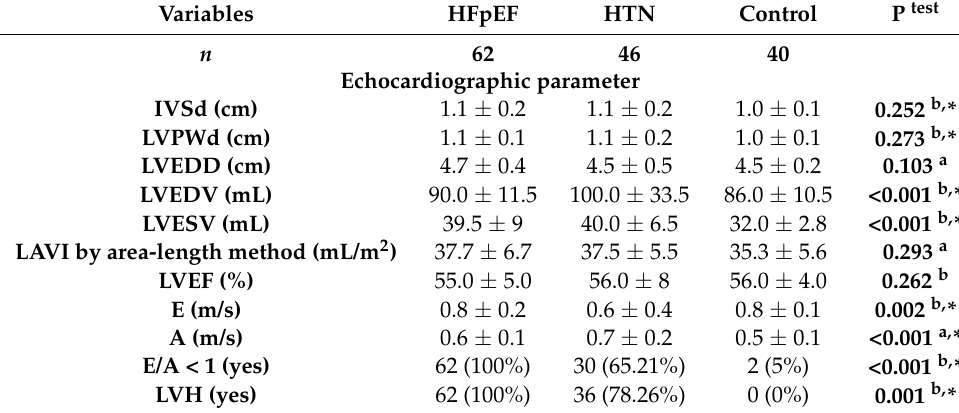
Table 4. Echocardiographic data for all patients ( n =